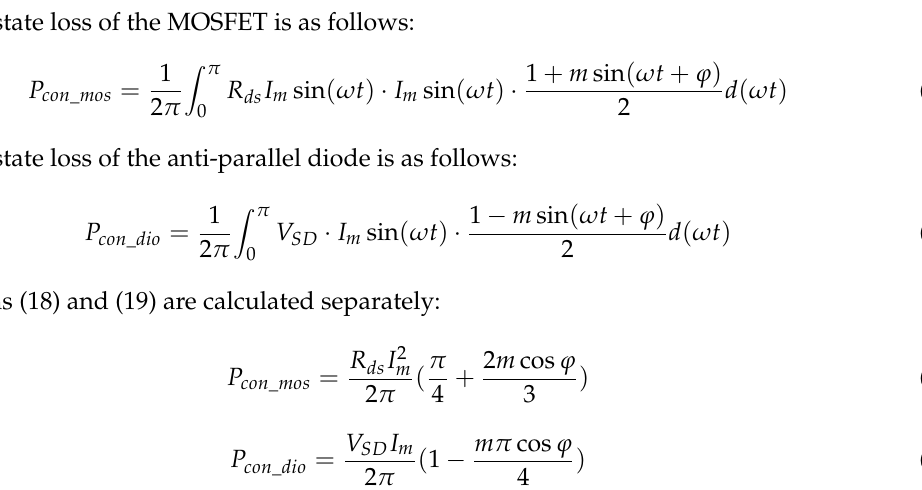
Figure 6. Partial partition of AC output of two-level inverter.